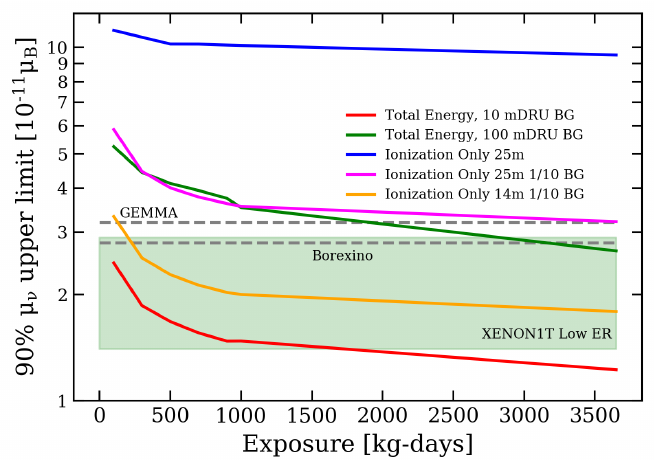
Figure 4. Sensitivity (median 90% upper limit) to neutrino magnetic moment from reactor neutrinos interaction in a liquid xenon detector, using either the ionization-only analysis for sub-keV energy events or the total energy for events above 1 keV. For the ionization-only approach, we compare the sensitivity between the standard assumptions (see Section 2) and more aggressive assumptions with reduced (1/10) S2-only background or placing the detector closer to the reactor core, from 25 m to 14 m, to increase the neutrino flux. For the “total energy” analysis, we assume 100 mDRU (10 mDRU) ER background, which is achievable in a liquid xenon detector with 10 ∼ 100 kg target mass. The upper limits (dashed horizontal lines) from GEMMA [53] and Borexino [49] experiments, as well as the allowed range (shaded green) from the excess of low energy electronic recoil events in XENON1T [45] are plotted for